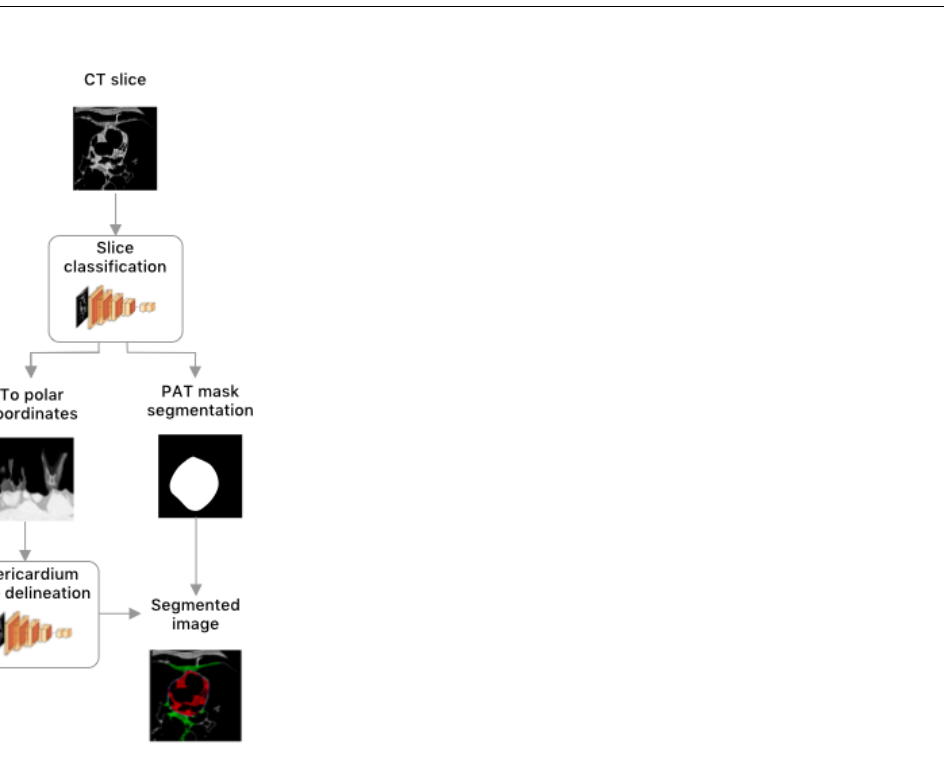
Figure 10. A summary of the method presented in Commandeur et al. [7]. A CNN is first used to obtain a PAT mask, which is used to resample the input CT slice. The slice, converted to radial coordinates, is fed into a second CNN which delineates the pericardium line. The pericardium line and PAT mask are used to segment the image into EAT and PAT.